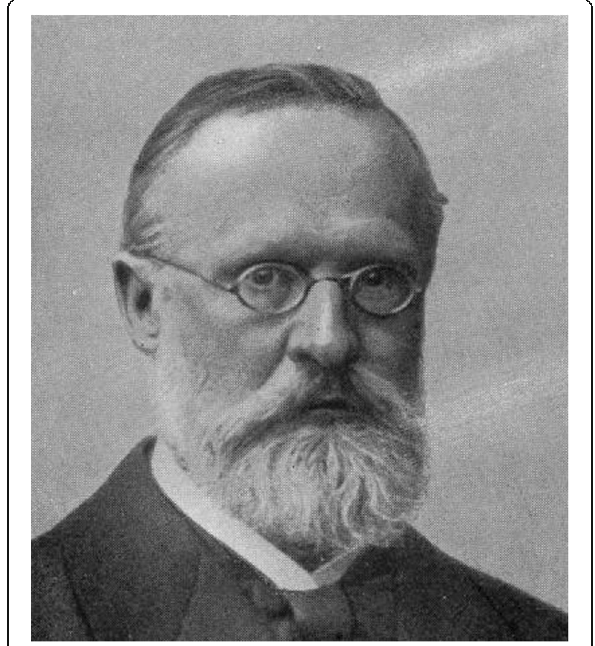
Fig. 1 Wilhelm Erb (1840 – 1921) [Collection Wellcome Images,